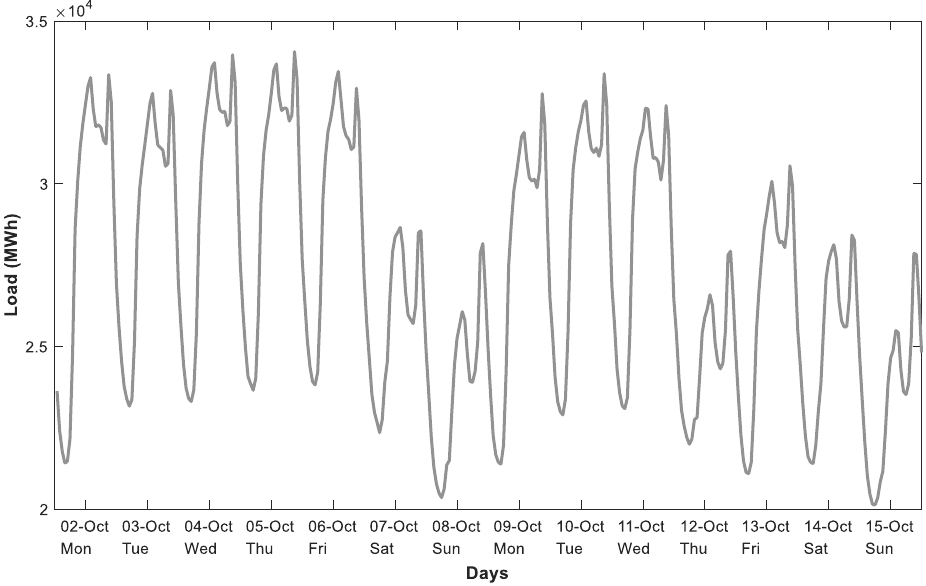
Figure 2. Hourly electricity demand in Spain from 2 October 2017 to 15 October 2017.